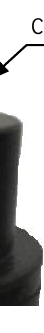
Figure 4 . Structure of sensor head. Figure 4. Structure of sensor